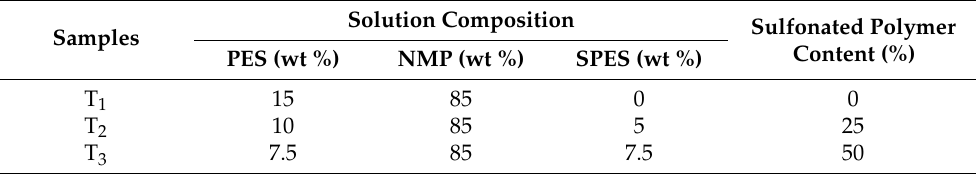
Table 1. Compositions of the casting